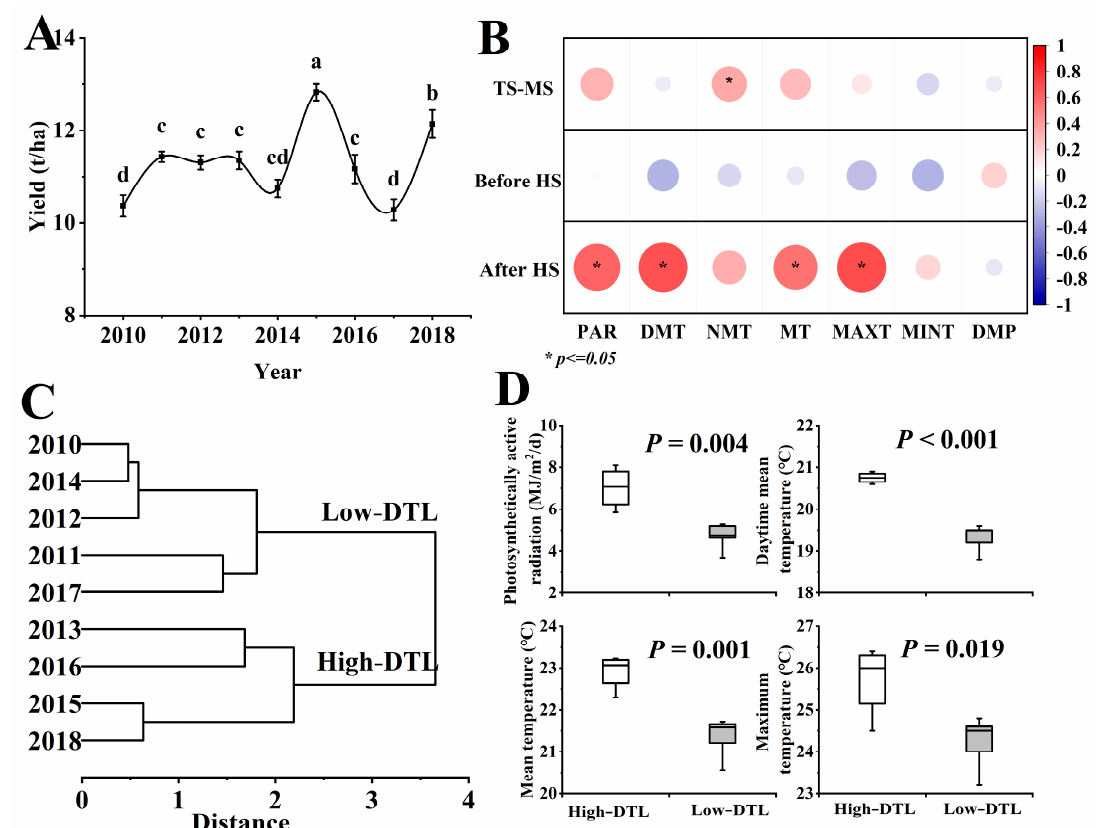
Figure 2. Annual average rice yield ( A ), the relationship between yield and meteorological param- eters ( B ), the cluster analysis of temperature and light parameters after heading that were significantly related to yield ( C ), and meteorological parameters after heading (PAR, DMT, MT, MAXT) between the High-DTL and Low-DTL ( D ). The different lowercase letters indicate the difference in nutrient absorption among treatments at the p < 0.05 level under High-DTL and Low-DTL, respectively. Note: PAR: Photosynthetically active radiation; DMT: Daytime mean temperature; NMT: Night mean temperature; MT: Mean temperature; MAXT: Maximum temperature; MINT: Minimum temperature; DMP: Daily precipitation; TP: transplanting stage; HS: heading stage; High-DTL: High daytime temperature and light after heading; Low-DTL: Low daytime temperature and light after